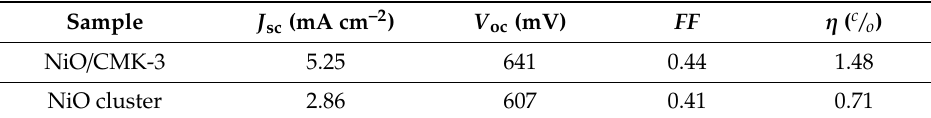
Table 1. Detailed photovoltaic parameters of the as-prepared p